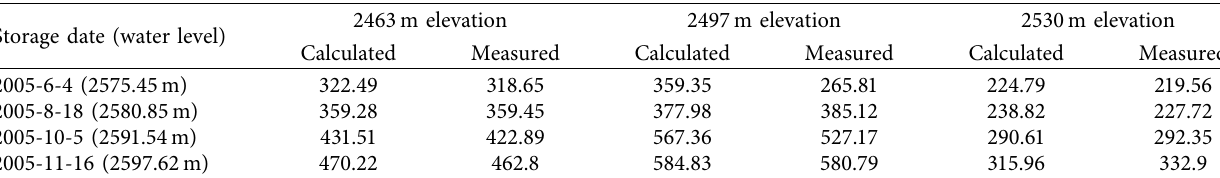
120 + A 2 fault (mL/s).